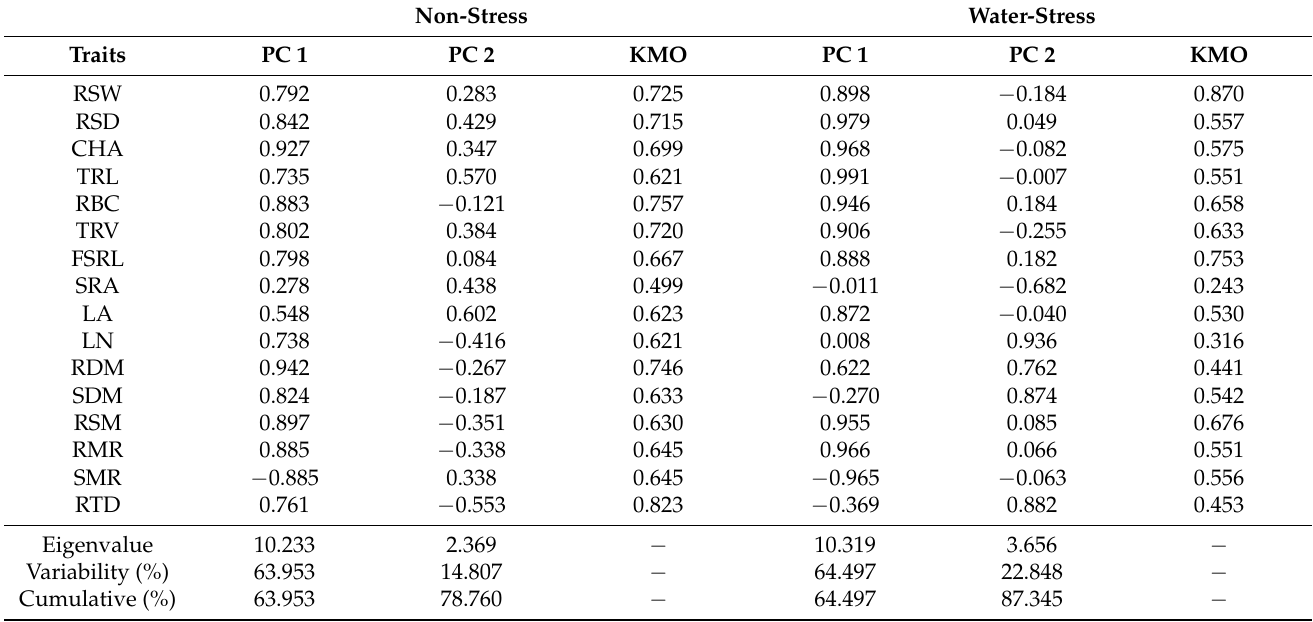
Table 6. Factor loadings, eigenvalue, Kaiser-Meyer-Olkin measure of sampling adequacy, percent and cumulative variation for root and leaf traits of nine citron watermelon accessions evaluated under non-stress and water-stress